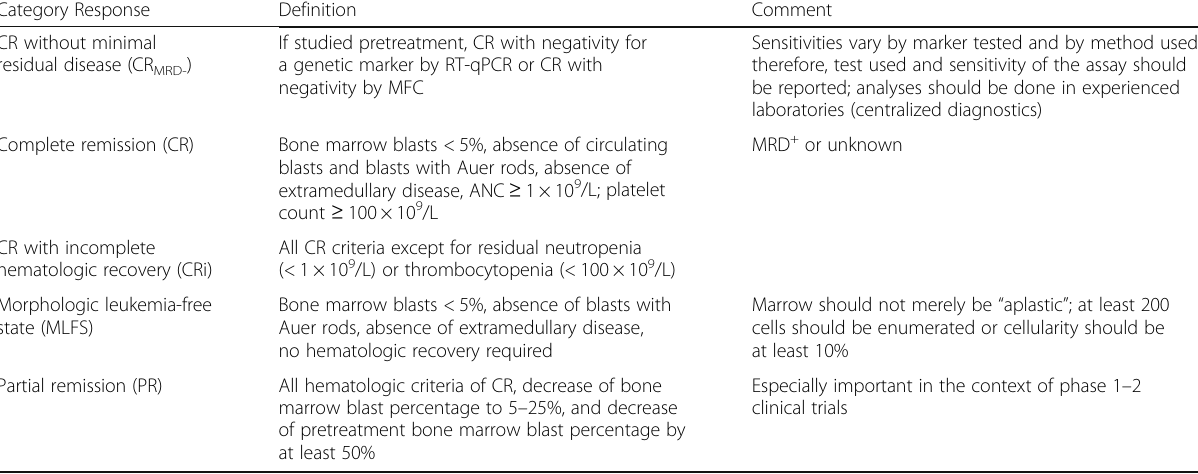
Table 1 Response categories according to ELN AML recommendations guidelines